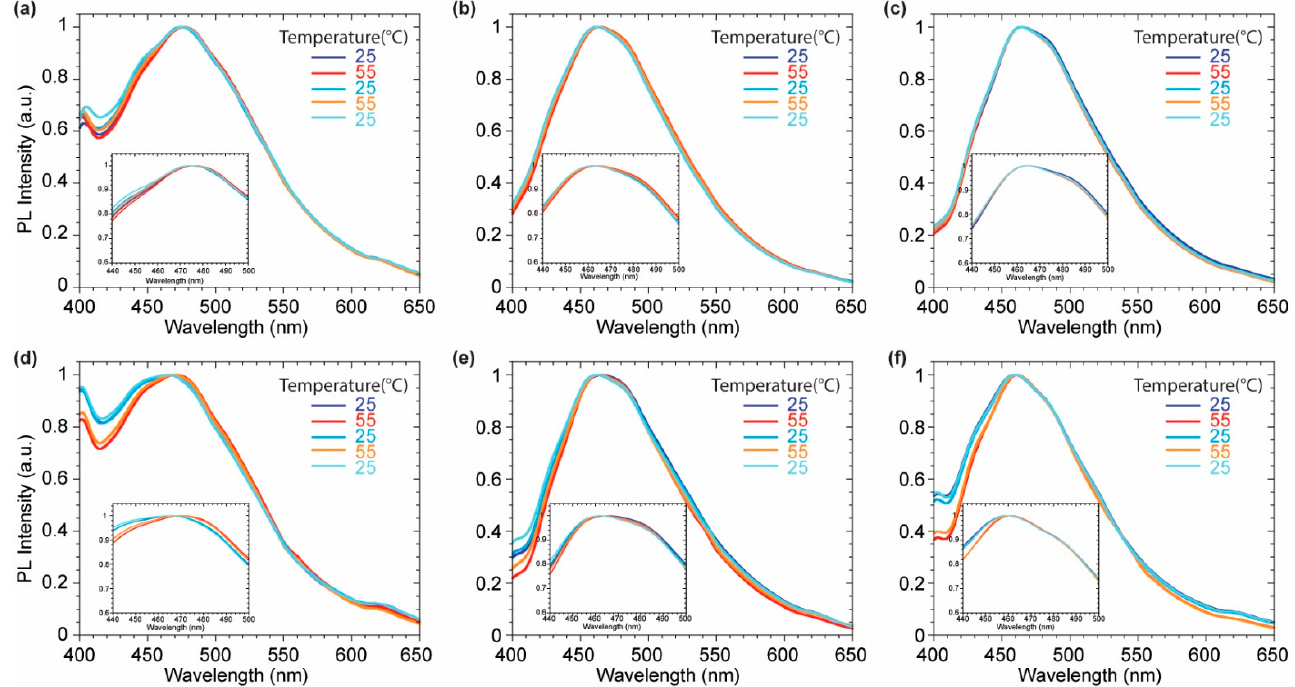
Figure 6. Normalized emission spectra of compounds 2 ( a , d ), 3 ( b , e ), 4 ( c , f ) in DOPC ( a – c ) and DPPC ( d – f ) over the heating cycles.